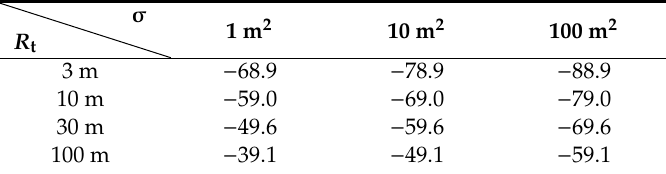
Table 7. Calculated values of the LO phase noise pedestal ( L Pb ) (dBc / Hz) causing degradation of the SNR Rt by 1 dB; the degradation relates to the middle target when generating three targets with identical RCSs and a critical R tc = 2 m